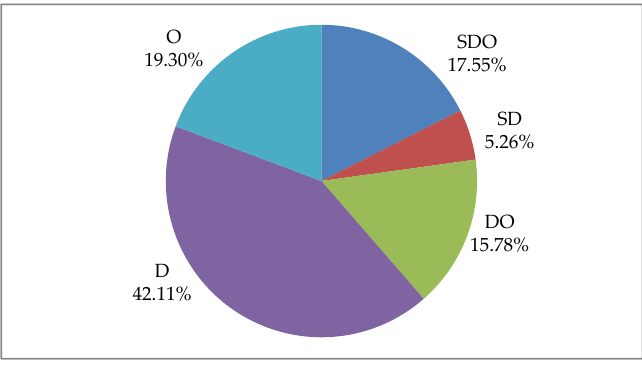
Figure 1. Distribution of number of articles to optimization types.